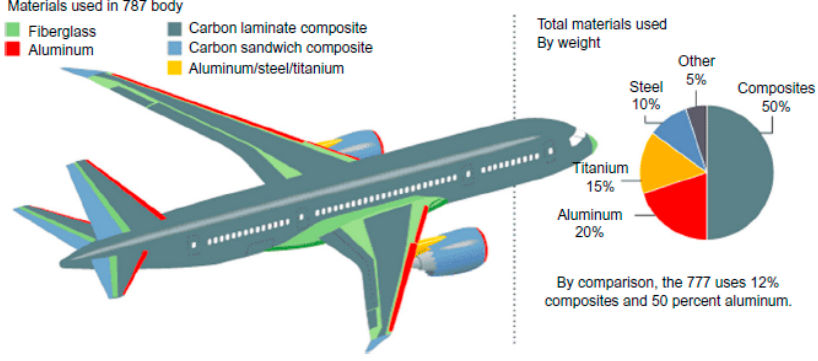
Figure 1. Dreamliner and its use of structural composites [4].